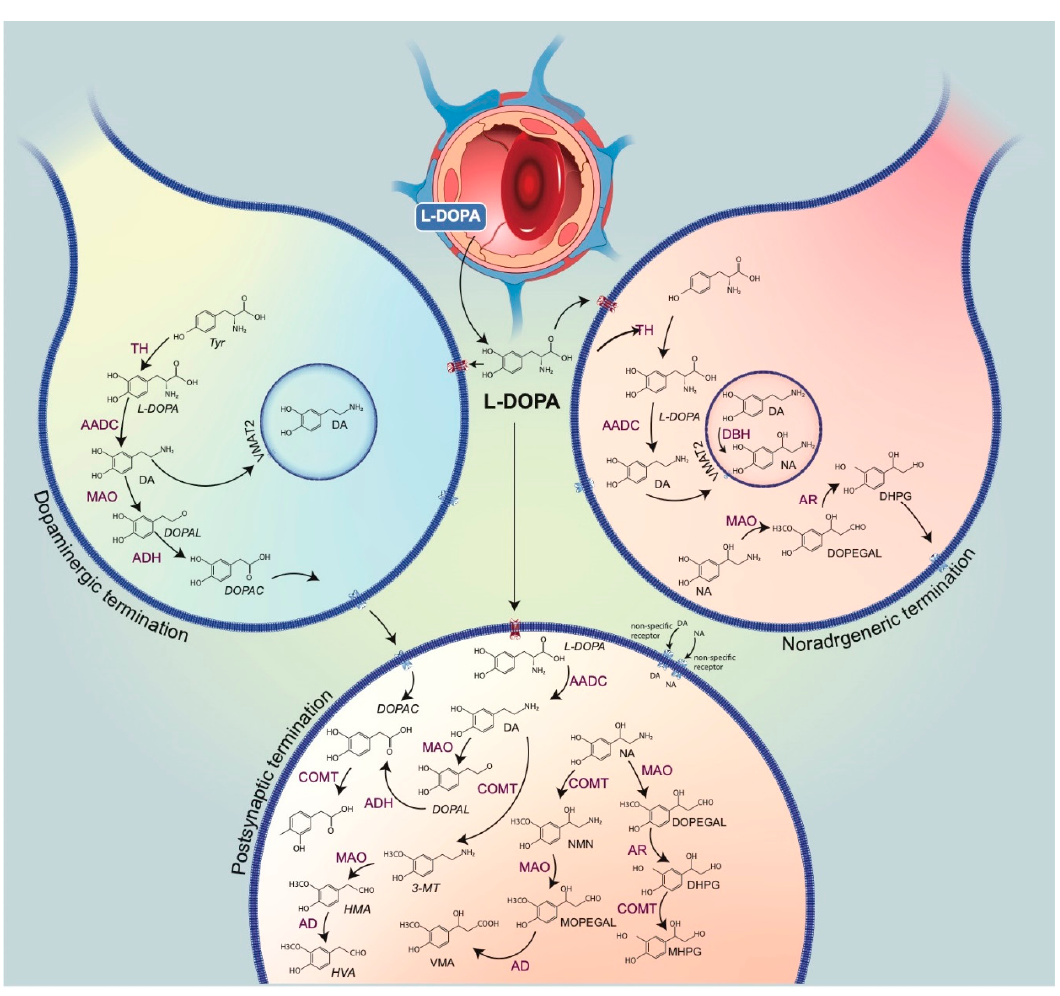
Figure 2. Metabolic pathways of catecholaminergic neurons. This drawing represents terminals of the dopamine (DA) neuron (left) and noradrenaline (NA) (right), a capillary, and a post-synaptic cell. L-3,4-dihydroxyphenylalanine (L-DOPA), normally synthesized from the amino acid tyrosine through hydroxylation by the enzyme tyrosine hydroxylase (the rate-limiting enzyme of catecholamine biosynthesis), can virtually reach all cells upon its exogenous administration. Neurons expressing the L-aromatic acid decarboxylase (AADC) can convert L-DOPA into DA. In monoaminergic cells, the vesicular monoamine transporter VMAT2 allows for the penetration of newly synthesized DA inside the vesicles of exocytosis. In NA terminals, DA is converted by dopamine ß-hydroxylase (DBH) to NA, mainly in vesicles. DA undergoes deamination, by monoamine oxidase (MAO), to form 3,4-dihydrophenylacetaldehyde (DOPAL), which is subsequently oxidized to 3,4-dihydroxyphenylacetic acid (DOPAC) by aldehyde dehydrogenase (AD). DOPAC leaves the dopaminergic cells and is then taken up by the postsynaptic cells. DOPAC is O-methylated by catechol- O -methyltransferase (COMT, not present in catecholaminergic neurons), generating homovanillic acid (HVA), the final metabolite. A similar circuit occurs with NA catabolism. NA can be converted into 3,4-methoxyphenylacetaldehyde (DOPEGAL) as a result of the action of MAO. DOPEGAL, which is reduced by aldehyde reductase (AR) to 3,4-dihydroxyphenylglycol (DHPG), is released out from the NA terminals. The final product of the NA metabolism is VMA, produced by post-synaptic cells. The post-synaptic pathways can be directly alimented by the nonspecific uptake of DA and NA or, upon L-DOPA administration, by the production of DA directly in the post-synaptic cells.